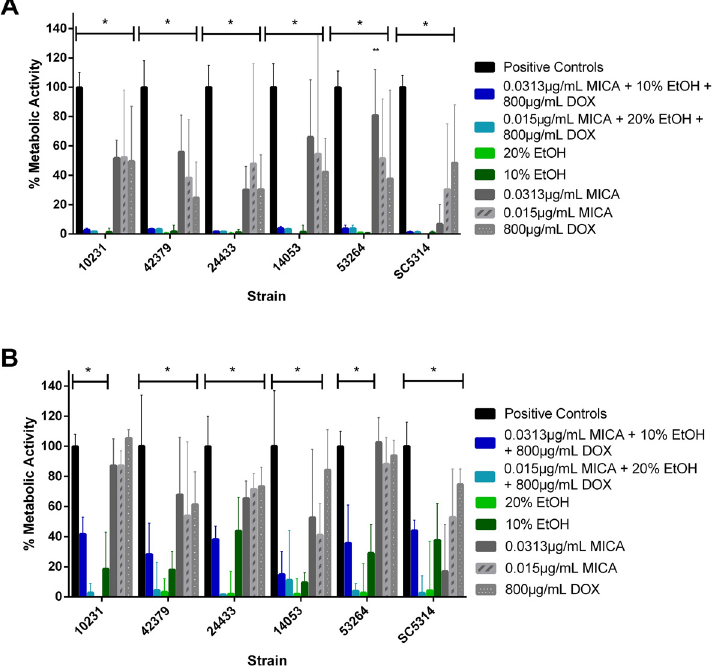
Fig 5. Prevention and treatment of clinical isolate and reference strain biofilm formation with optimized solutions. Fig 5a. Optimized solutions (OS 1, 20% ethanol, 0.015625 μ g/mL micafungin, 800 μ g/ mL doxycycline, and OS 2, 10% ethanol with 0.0313 μ g/mL micafungin and 800 μ g/mL doxycycline) were highly effective in preventing the formation of echinocandin-resistant clinical isolate and reference strain biofilms. Optimized solutions were incubated with C . albicans isolates for 24 hours at 37°C to prevent biofilm development and untreated positive controls were compared to drug treated groups with the same strain. Metabolic activity was measured with XTT reduction. * indicates p value of < 0 . 05 . ** 0.0313 μ g/mL was not significant compared to the control for strain 53264 only. Fig 5b. Optimized solutions (OS 1, 20% ethanol, 0.015625 μ g/mL micafungin, 800 μ g/mL doxycycline, and OS 2, 10% ethanol with 0.0313 μ g/mL micafungin and 800 μ g/mL doxycycline) significantly reduce the metabolic activity of echinocandin-resistant clinical isolates and reference strains. Optimized solutions were incubated with mature C . albicans biofilms for 24 hours at 37°C. Metabolic activity was measured with XTT reduction and untreated positive controls were compared to drug treated groups with the same strain. * indicates p value of < 0 .